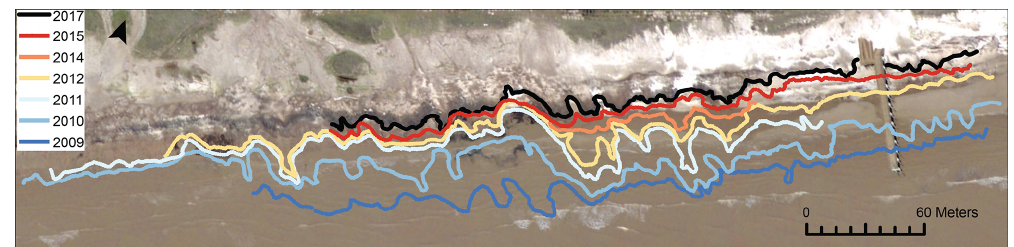
Figure 4. Plan view of shorelines delineated from subsequent approximately annual aerial images. Site 1 (see Fig. 1). Arrow points north. Image source: NOAA. Hurricane Harvey: Emergency Response Imagery of the Surrounding Regions,